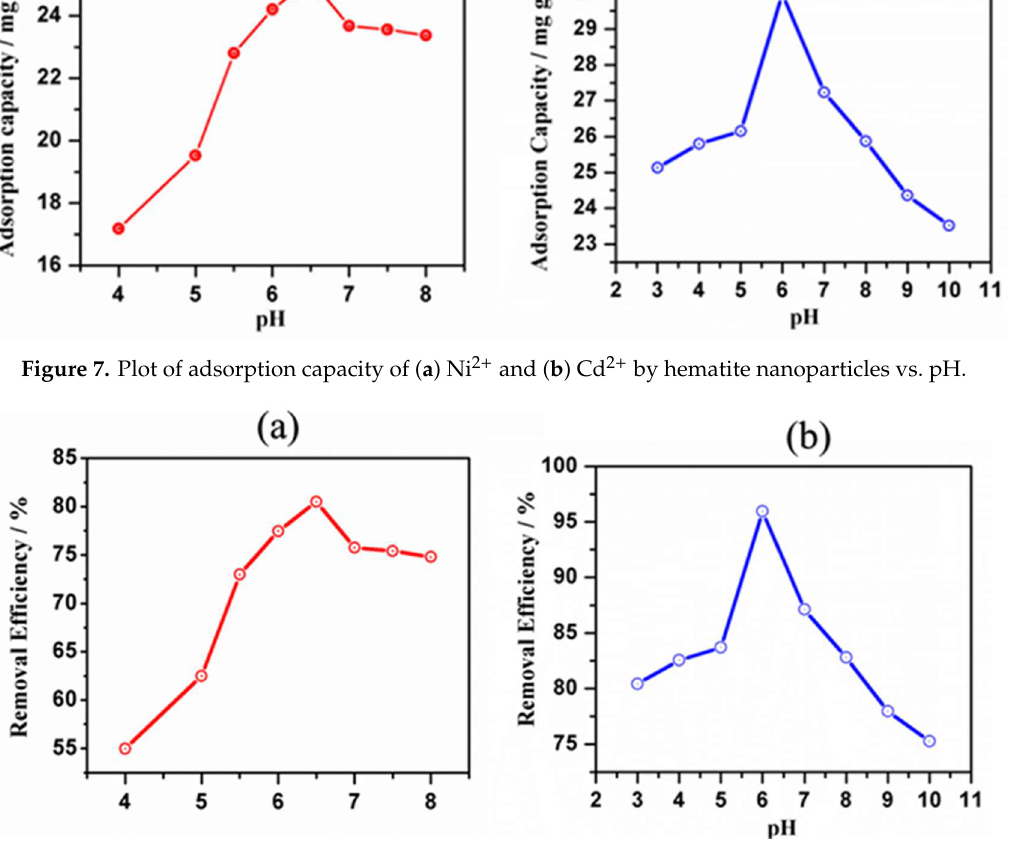
Figure 9. Plot of amount adsorbed of ( a ) Ni 2+ and ( b ) Cd 2+ ions by hematite nanoparticles with